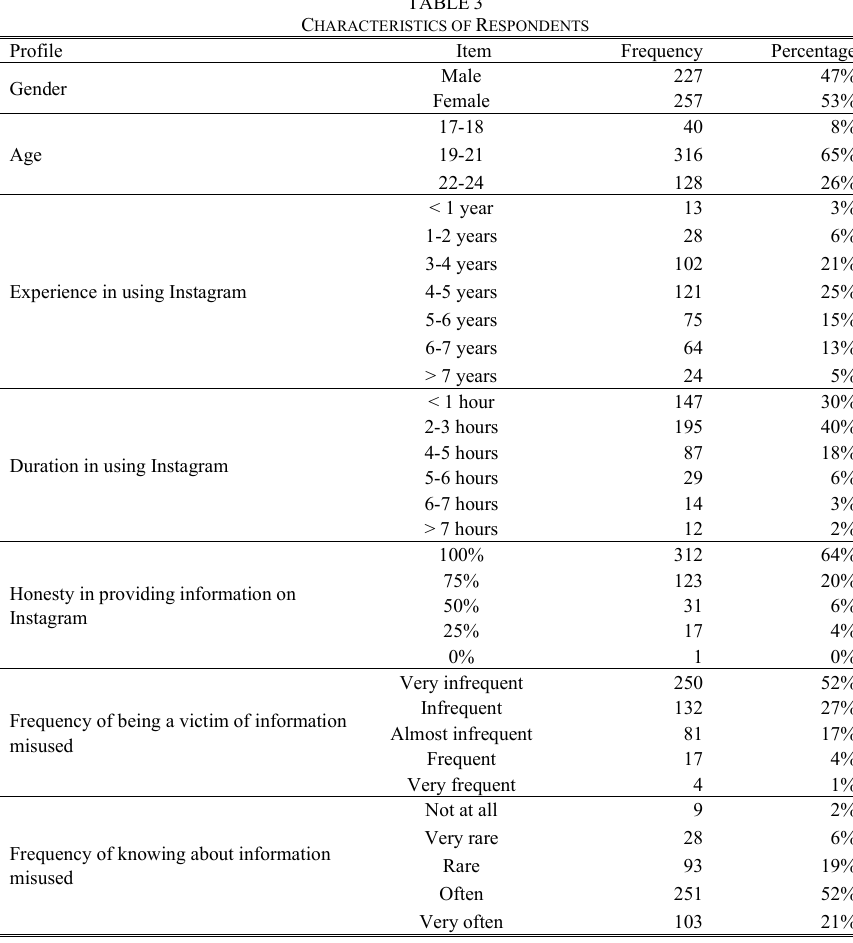
TABLE 3 C HARACTERISTICS OF R